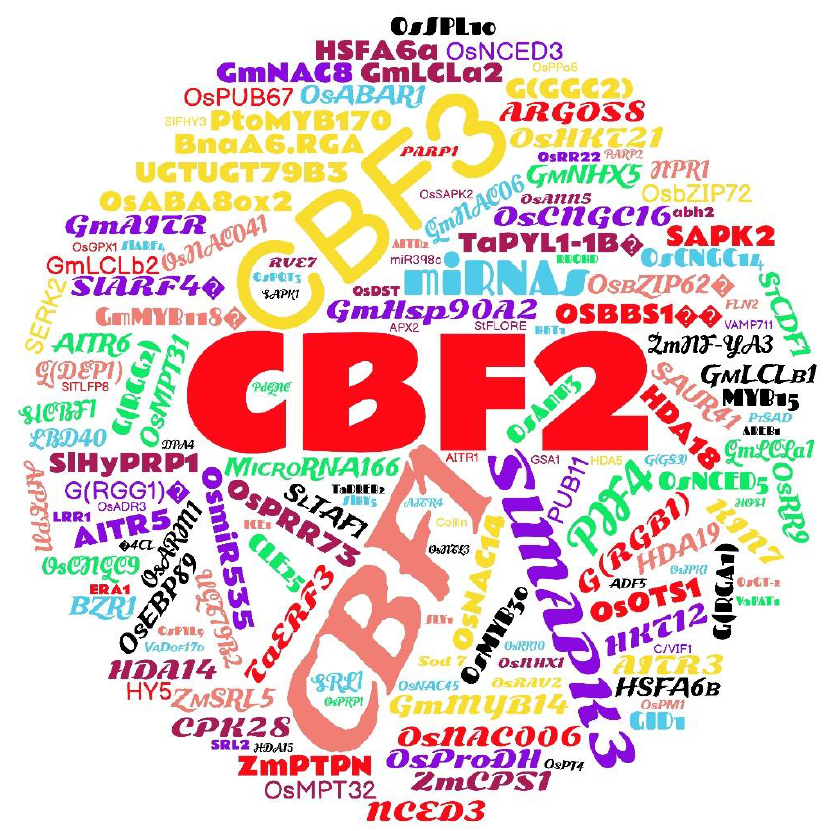
Figure 7. Word cloud of genes related to abiotic stresses identified in studies that used CRISPR/Cas gene-editing technology in the last seven years.